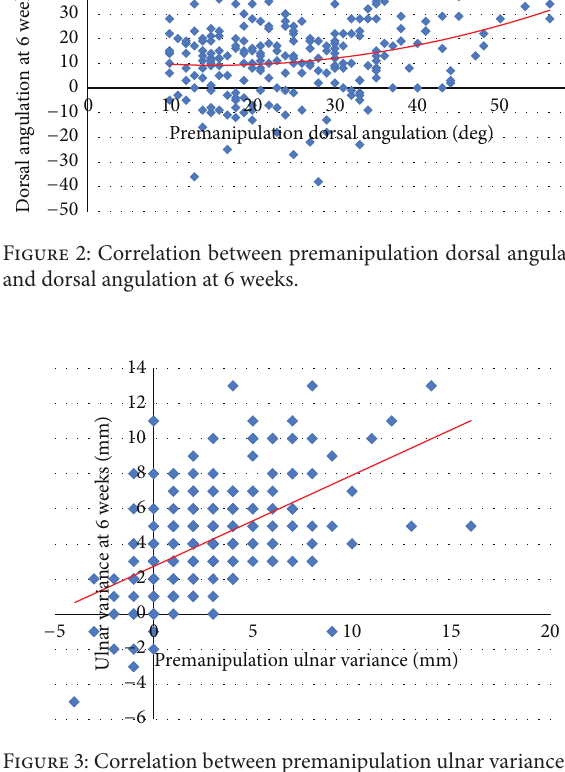
Figure 3: Correlation between premanipulation ulnar variance and ulnar variance at 6